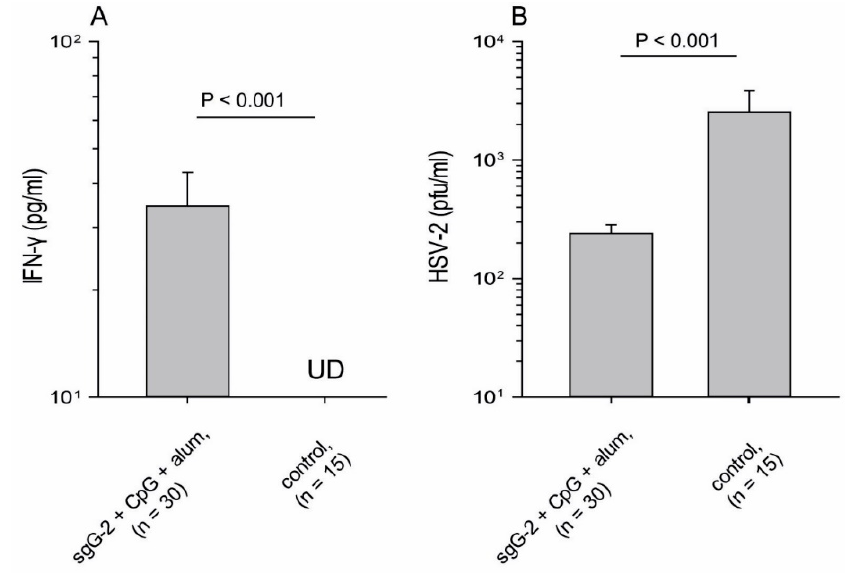
Figure 4. Significant increase of IFN- γ concentration and reduction of viral load in vaginal washes from sgG-2 + adjuvant i.m. immunized mice as compared with PBS vaccinated controls. ( A ) ELISA was used to detect IFN- γ in vaginal secretions at day one post challenge with HSV-2 333; ( B ) Infectious viral particles (PFU) at day three post challenge were detected by titration on African green monkey kidney (GMK-AH1) cells. The detection limit was 20 PFU/sample. UD; undetectable < 10 pg/mL. Data are shown from three separate experiments. Mean values and error bars + SEM are indicated.